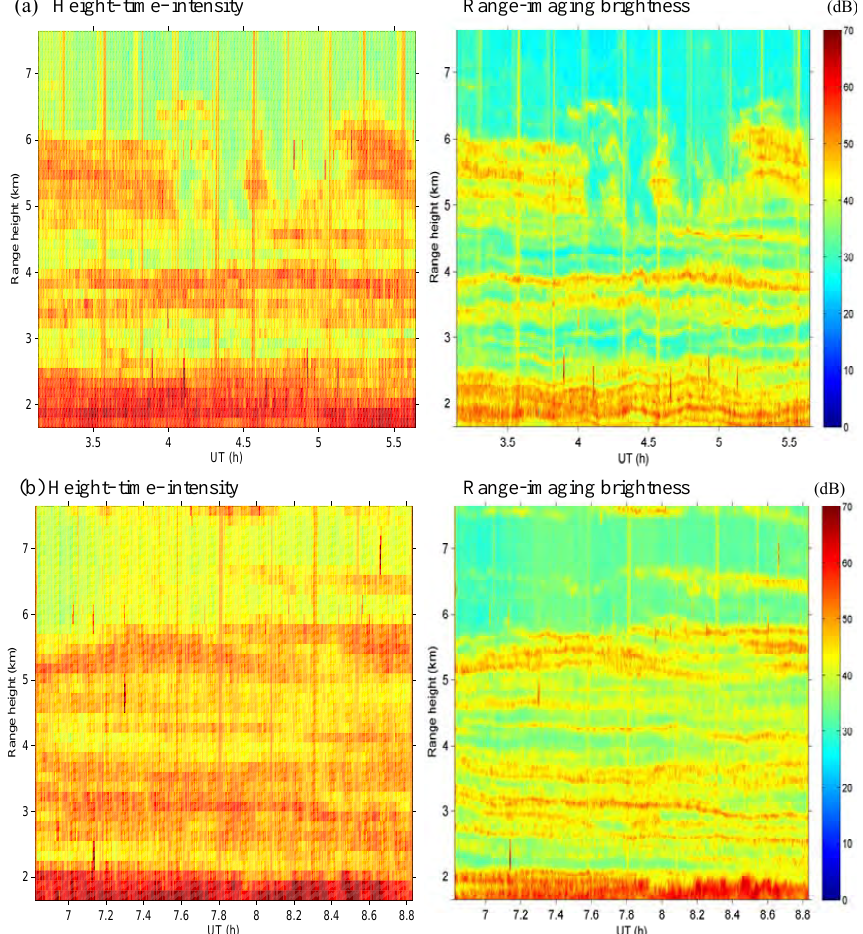
Figure 4. (a) (Left) Height–time–intensity with a range resolution of 150m, and (right) range imaging with a range step of 1m. (b) is similar Figure 3: (a) (Left) High-time intensity with a range resolution of 150 m, and (right) to (a) , but the radar data were collected later on the same day (9 November range imaging with a range step of 1 m. (b) is similar to (a), but the radar data were collected later on the same day (9 November 2009).